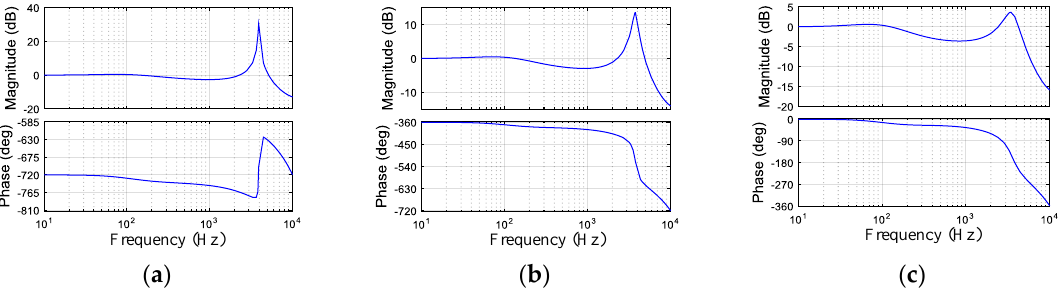
Figure 11. Bode diagrams of voltage closed-loop transfer function: ( a ) τ = 2.5 T s ; ( b ) τ = 3 T s ; ( c ) τ = 4 T s .